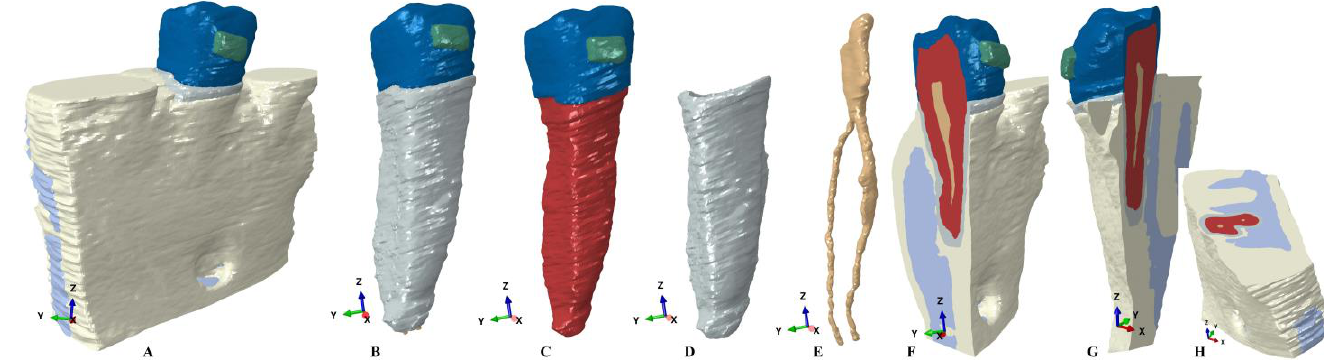
Figure 2. 3D model without the mesh borders: ( A ) 2nd lower right premolar model with intact periodontium; ( B ) 2nd lower right premolar model with intact PDL and NVB; ( C ) 2nd lower right premolar model; ( D ) 2nd lower right premolar’s intact PDL; ( E ) 2nd lower right premolar’s dental pulp and NVB; ( F – H ) 3D model different sections.